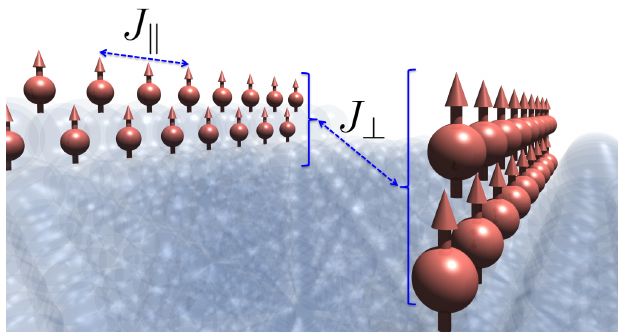
Figure 2. Schematic diagram showing the magnetic interactions of Fe wires. J (cid:107) : Intrawire exchange coupling, and J ⊥ : Interwire exchange